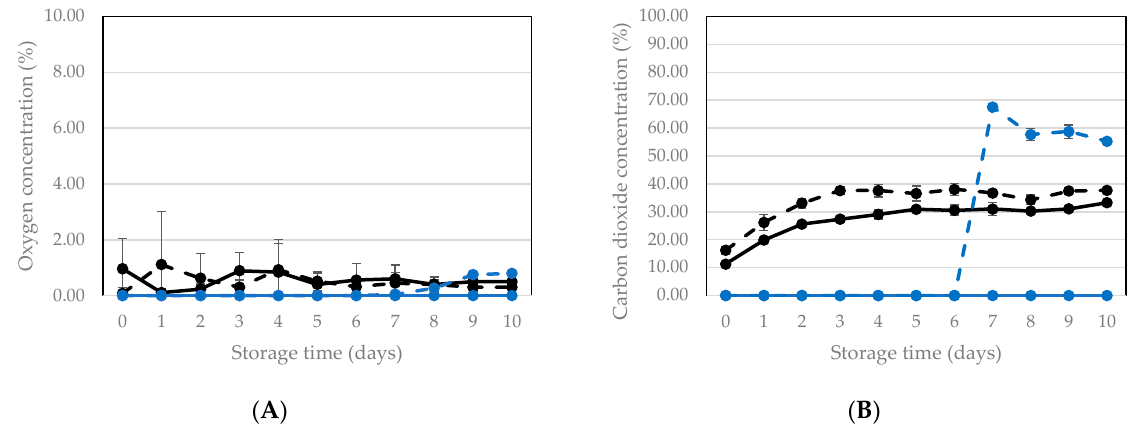
Figure 6. Oxygen ( A ) and carbon dioxide ( B ) concentration during storage at 15 °C of packages of living larvae that were only sealed (no vacuum = control) and that were vacuum packaged prior to storage. At day 0 and 1, data points are the mean of 10 packages ( n = 10). Afterwards, each day there was one replicate less, since one package was opened to determine survival. Vertical bars are standard deviations. Two experiments were performed with different batches of larvae: Control 1: black, full line, Control 2: black dashed line, Vacuum 1: blue, full line, Vacuum 2: blue dashed line.